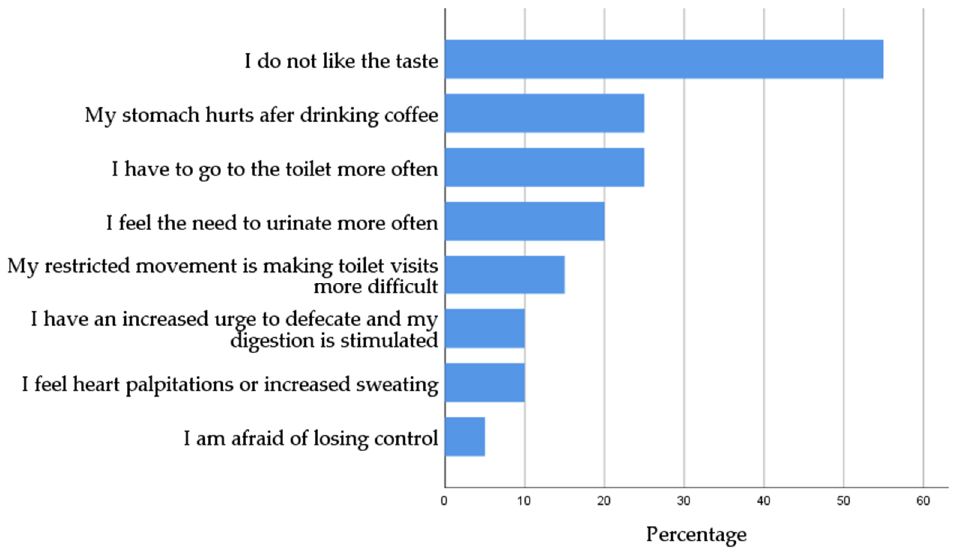
Figure 3. Reasons for patients not to drink co ff ee indicated in percentages.